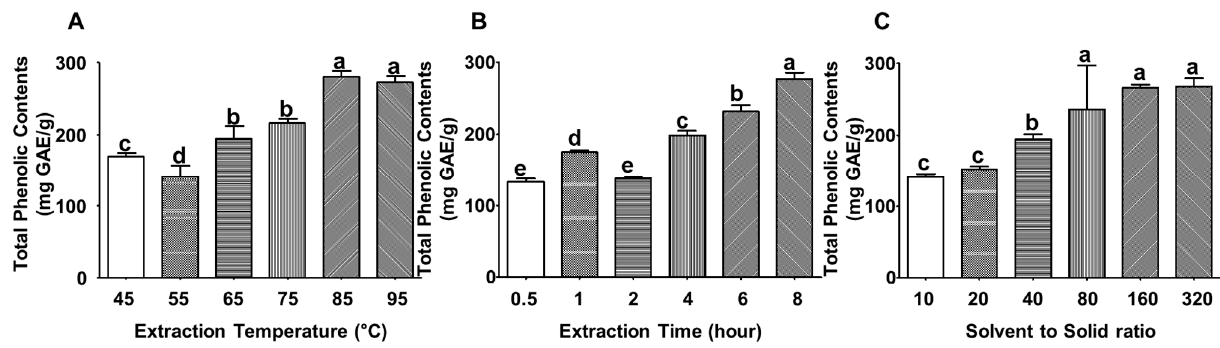
Figure 1. Measurement of total polyphenolic contents by changing the extraction time, the extraction temperature, and the solvent-to-solid ratio during hydrothermal extraction of Acer tegmentosum. ( A ) Extraction temperature varied from 45–95 °C, and extraction time and solvent-to-solid ratio were fixed at 2 h and 80, respectively. ( B ) Extraction time varied from 0.5–8 h, and extraction temperature and solvent-to-solid ratio were fixed at 85 °C and 80, respectively. ( C ) Solvent-to-solid ratio varied from 10–320, and extraction temperature and extraction time were fixed at 85 °C and 2 h, respectively. Data are presented as the mean ± standard deviation ( n = 3). Labeled averages without a common letter differ. p < 0.05.